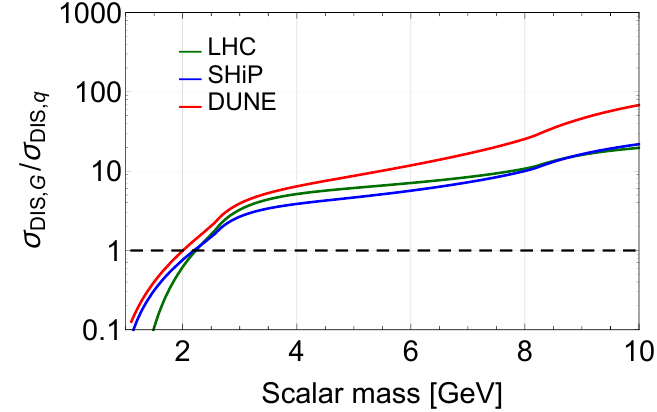
Figure 4 . The ratio of cross sections of the scalar production in deep inelastic scattering via gluon and quark fusion. The dashed line corresponds to a ratio equal to unity. \LHC", \SHiP" and \DUNE" denote correspondingly the results for the proton-proton center-of-mass energies p s pp = 13 TeV, p s pp = 28 GeV and p s pp = 16